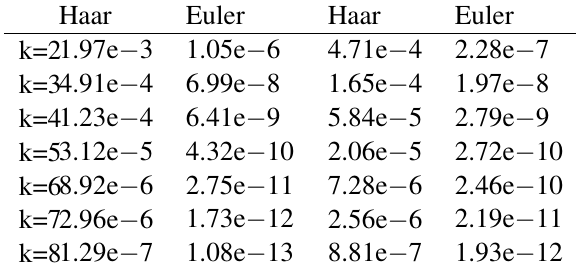
Table 4 L ∞ and L2 errors under different parameters